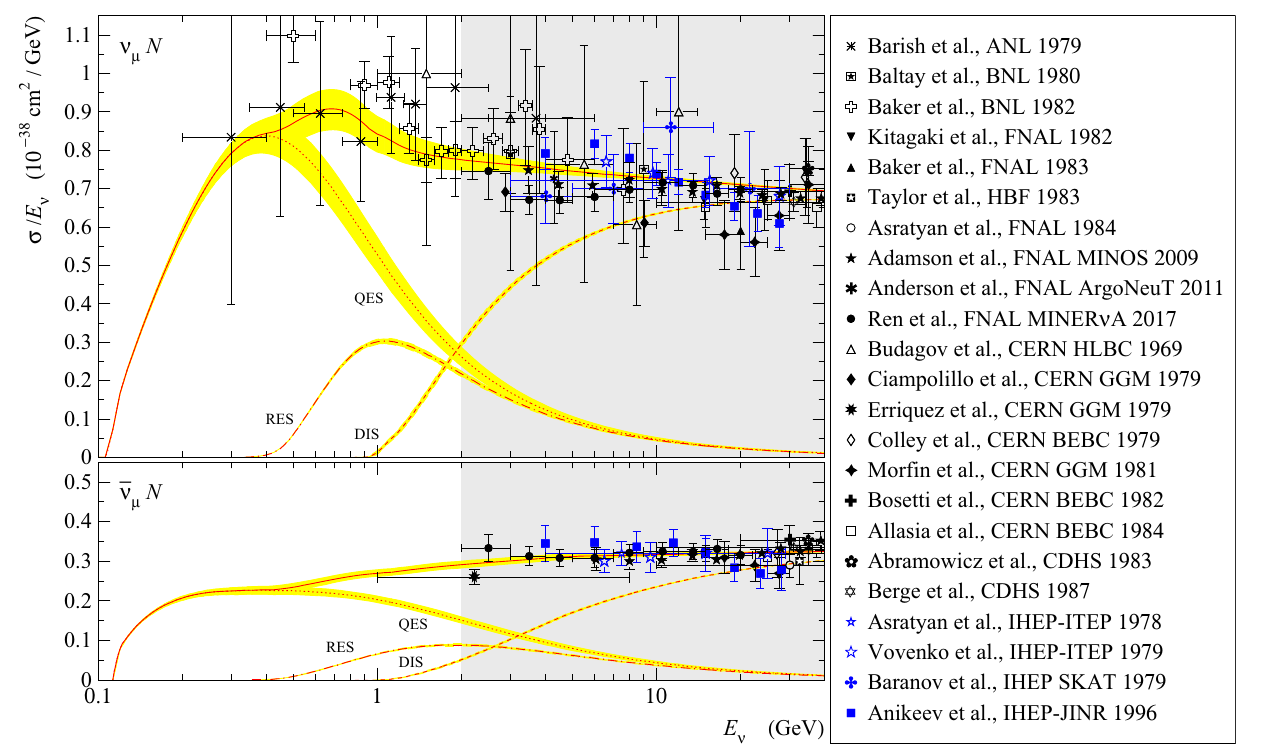
Fig. 11 Total CC cross sections as functions of (anti)neutrino energy andnormalizedtoenergyfor ν μ and ν μ scatteringoffisoscalarnucleons in comparison with experimental data [43–70]. The curves and bands of theoretical uncertainties show the QES [71] (with contribution from